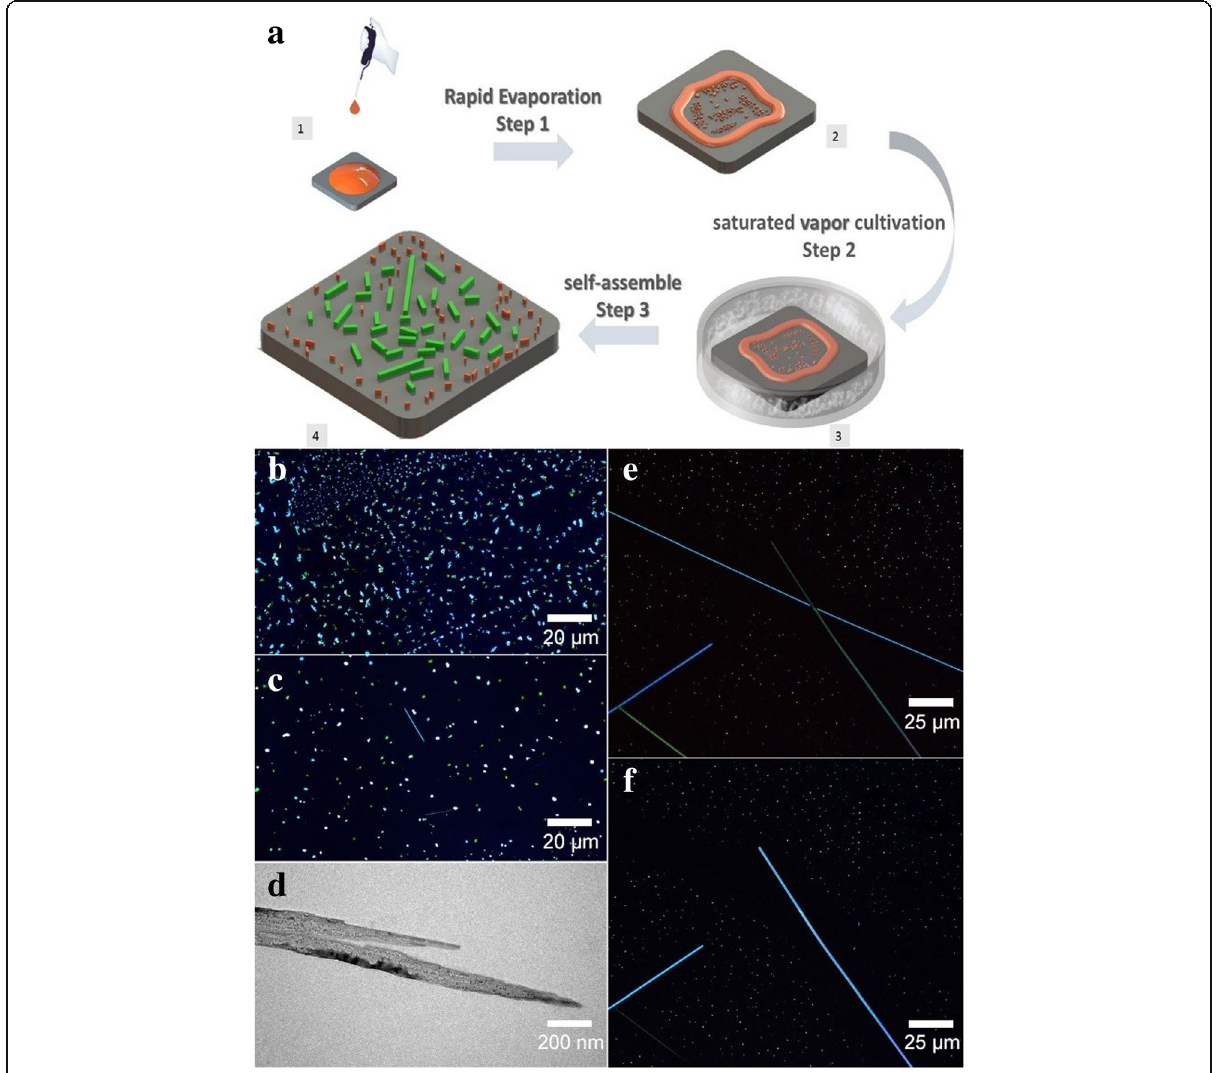
Fig. 1 a The schematic of the one-drop self-assembly method. b The fluorescence image of DAST crystal after the SSREC process. c After 40 min of cultivation in a methanol atmosphere. d The BTEM image of unfinished DAST NW. e After 2.5 h of cultivation in a methanol atmosphere. f After 2.5 h of cultivation in a methanol atmosphere with the cross-polarizer rotated by